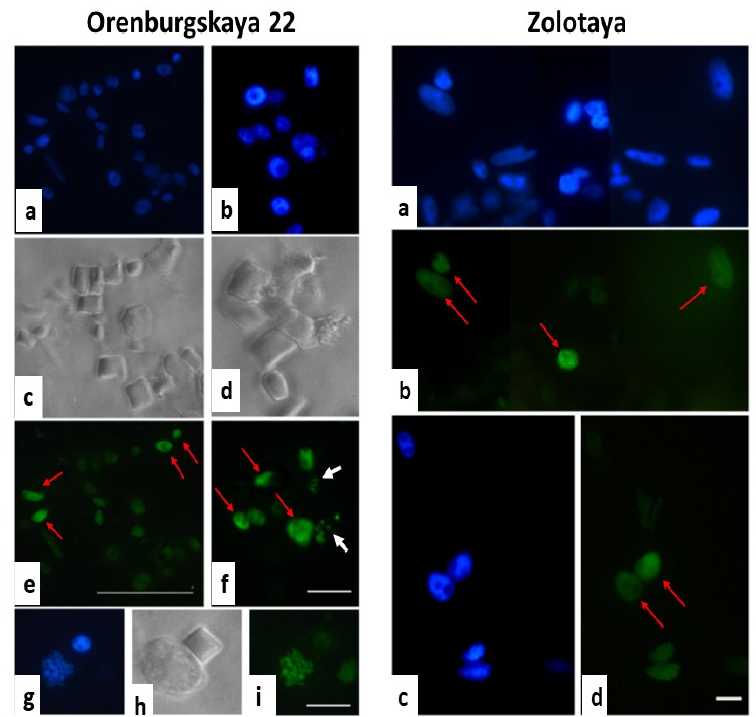
Figure 7. Localization of phosphatidylserine on the surface of plasma membranes of root cells of 4-day- old seedlings of Triticum durum variety Zolotaya in the presence of 150 mM NaCl. ( a , c )—Clusters of phosphatidylserine on surface plasmatic membranes (Annexin V-FITC), blue arrows; ( b , d )—nuclei of cells (DAPI). Bar 200 µ m.